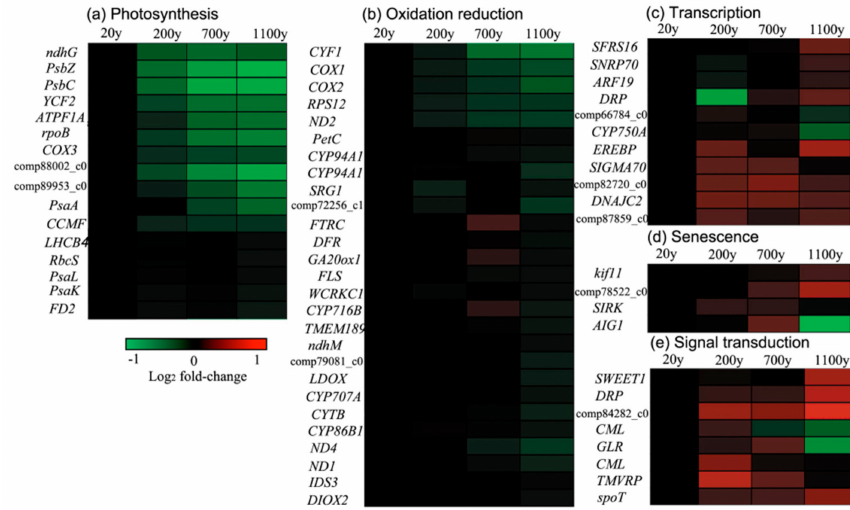
Figure 9. Genes representing di ff erent functional classes and showing age-dependent changes in transcript level: ( a ) Photosynthesis, ( b ) Oxidation Reduction, ( c ) Transcription, ( d ) Senescence and ( e ) Signal